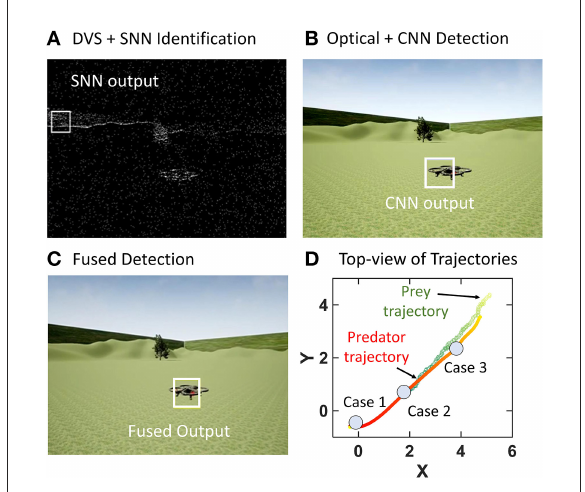
FIGURE5 Illustration from an intermediate step in case 2 where an incorrect SNN output is ignored by the fusion algorithm to use the CNN output as the fused output. (A) SNN Output. (B) CNN output. (C) Target position after fusion using CNN output instead of noisy SNN output. (D) Top view of trajectory as predator goes through cases outlined in Section 2.3. The intensity of the colors corresponds to the time-step for both prey and